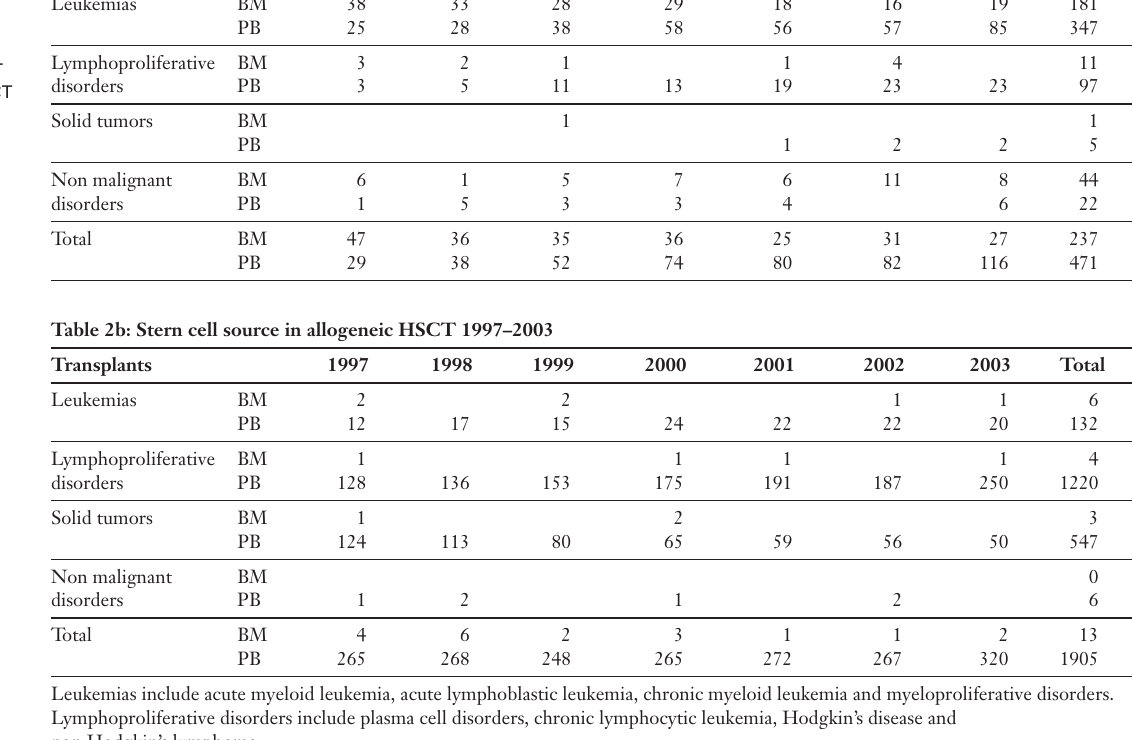
Table 2a: Stern cell source in allogeneic HSCT 1997–2003 Transplants